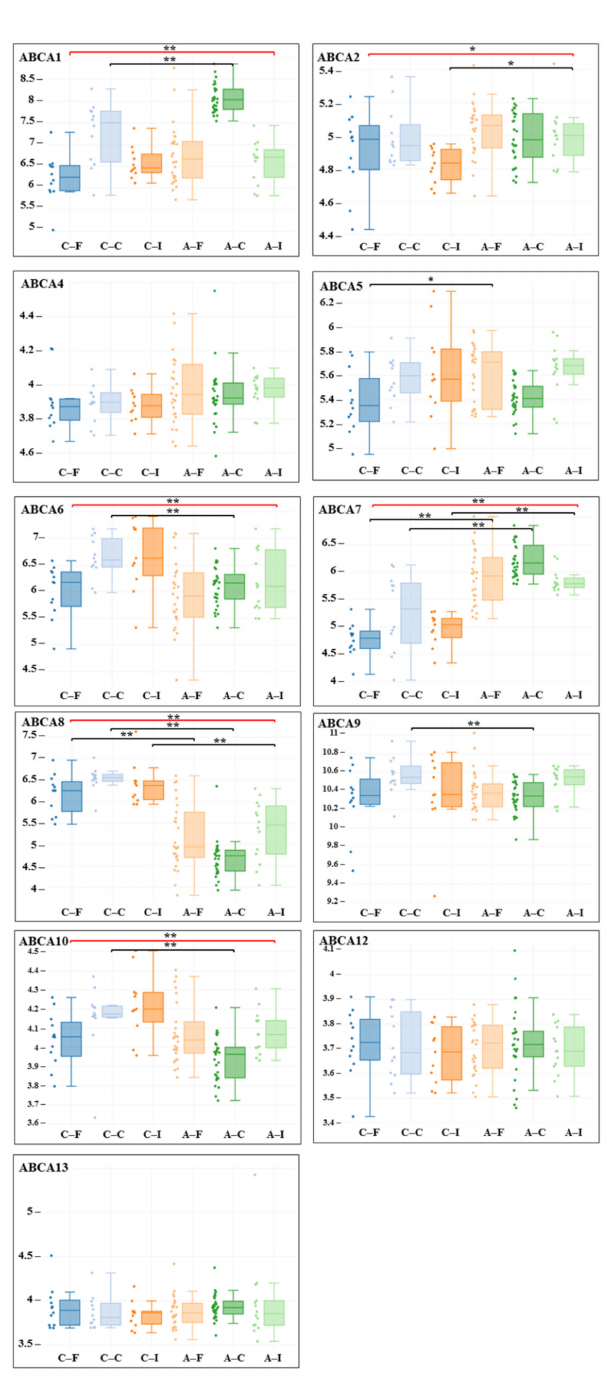
Figure 1. Gene expression patterns of the ABCA subfamily in the comparison groups: atherosclerotic— femoral artery (A–F); atherosclerotic—carotid artery (A–C); atherosclerotic—infrapopliteal artery (A–I); control—femoral artery (C–F); control—carotid artery (C–C); control—infrapopliteal artery (C–I). The red line shows the differences in gene expression in the group between all sets with atherosclerosis and all control sets. The data distribution is visualized in the form of box diagrams. Statistically significant differences ( p values adjusted using the algorithm of Benjamini–Hochberg (adj. P. Val)) shown with asterisks: * p < 0.05, ** p <